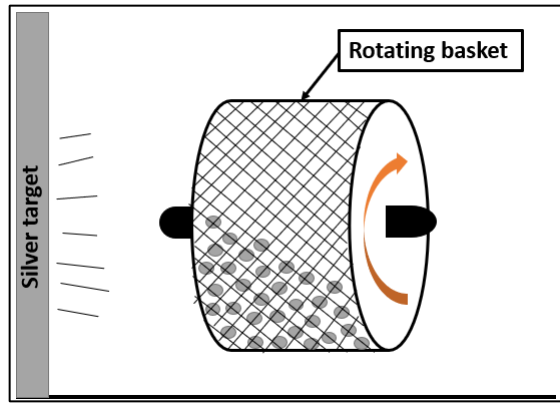
Figure 3. Schematic representation of the rotating basket, containing the Arboblend V2 Nature pel- lets and the silver